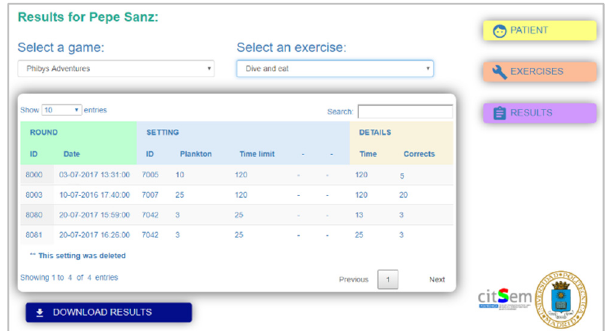
Fig. 14. Example for different configurations made over time for one exercise